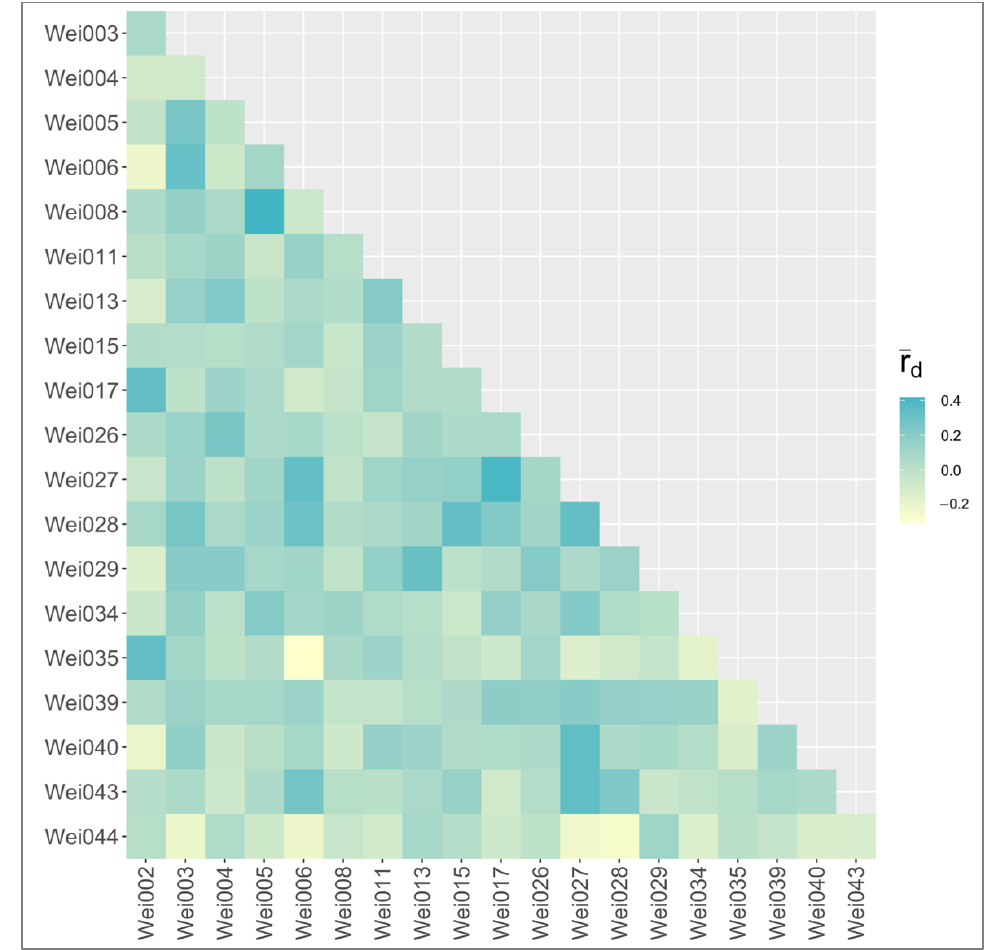
Figure 2. Pairwise linkage disequilibrium of all 20 genomic simple sequence repeat (gSSR) markers developed for Weigela cultivars. Pairwise 𝑟 𝑑 was calculated for each locus pair and visualized with a heatmap to infer any associations between loci. The darker the square, the more of an association there is between the pair of loci and vice versa.